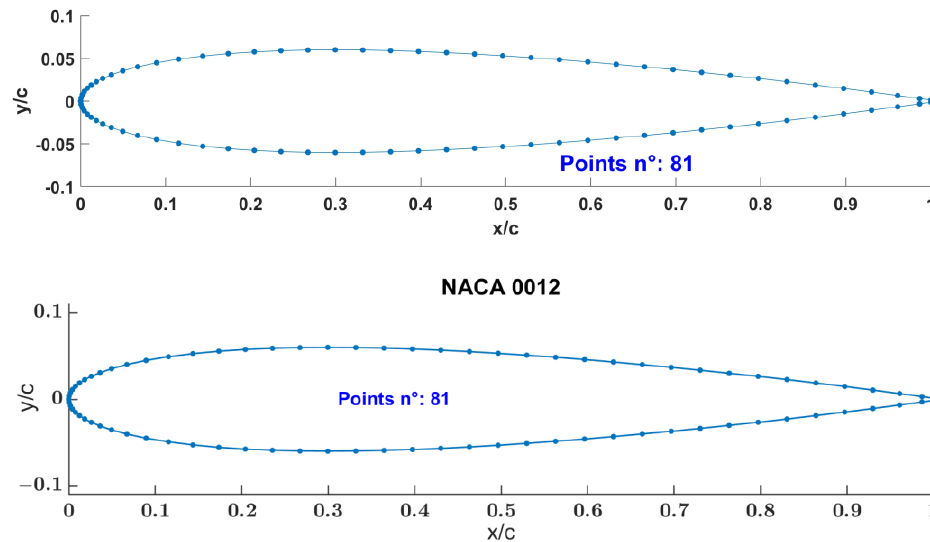
Figure 17. NACA 0012 input airfoil. Designs 2023 , 7 , x FOR PEER REVIEW